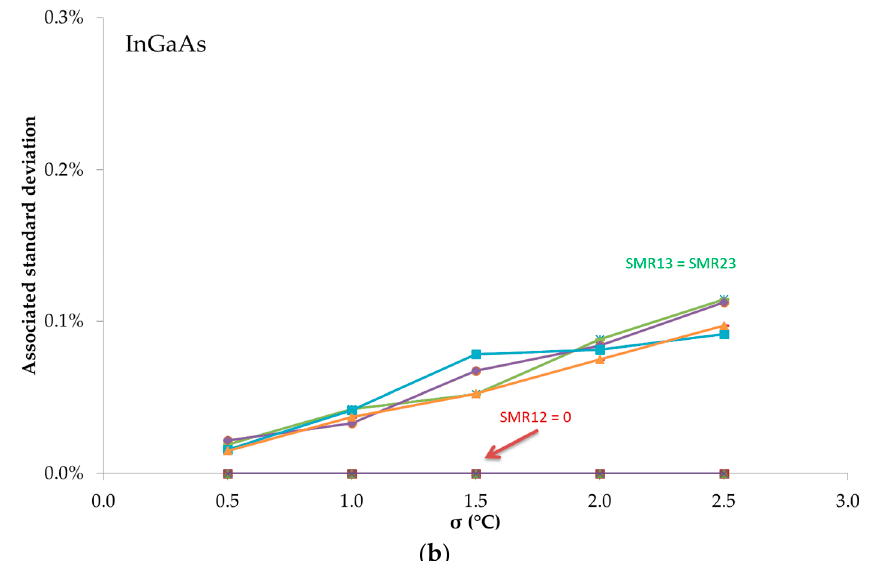
Figure 9. Uncertainties associated with spectroradiometer c-Si and InGaAs temperature errors, varying the amplitude of the temperature error. ( a ) crystalline silicon detector in the region 850 ≤ λ ≤ 1150 nm; ( b ) InGaAs detector in the region 1500 ≤ λ ≤ 1700 nm.